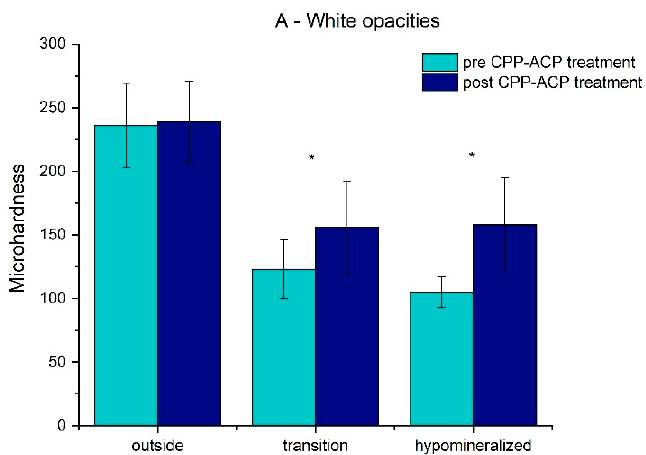
Figure 3. Bar chart of the mean values and standard deviation of microhardness in the white opacities group (* represent statistical significance).